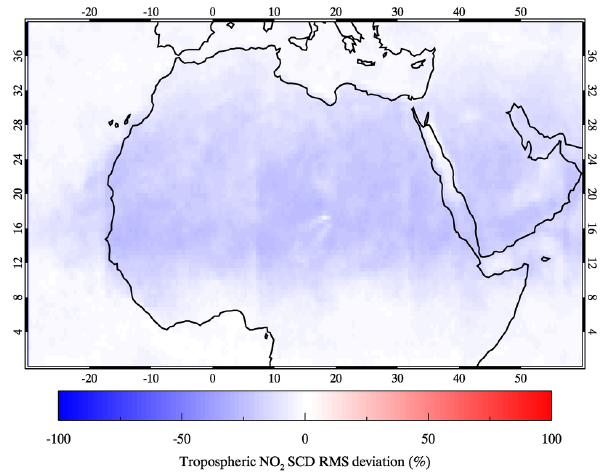
Figure 7. The change in rms resulting from adding the sand and liq- uid H 2 O absorption cross-sections to the Earth radiance reference DOAS fit. DOAS fits for OMI spectra measured over the Sahara desert during June 2005 were performed using a Pacific Earth radi- ance reference with and without the sand and liquid H 2 O absorption cross-section included (see Table